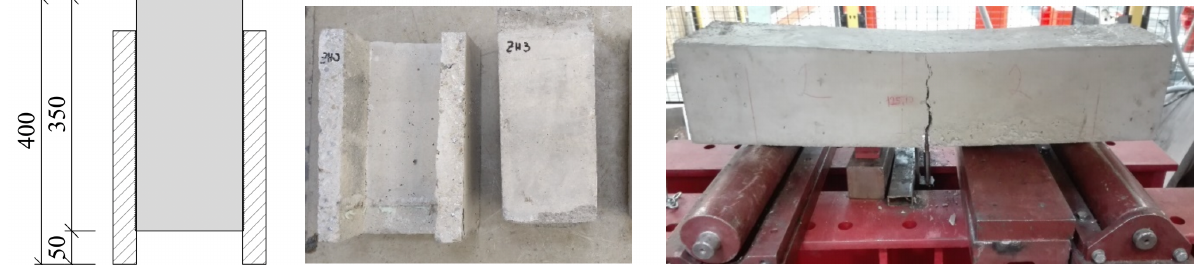
Figure 3. Push test and 3-point bending test, a) dimension of a push test, b) push test after the loading, c) sample after the 3-point bending